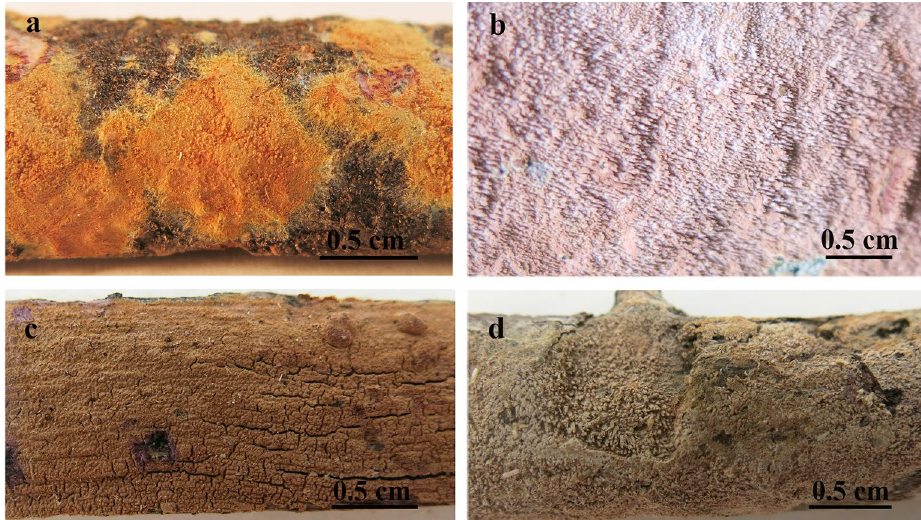
Figure 5. Xylodon magallanesii , ( a ) 20008Tell, MA-Fungi 90397, holotype, basidiome, dry specimen; ( b ) 15637MD, MA-Fungi 91819, basidiome, wet specimen. Xylodon australis , ( c ) P. Wellman 697, CANB 869100, basidiome, dry specimen. Xylodon lenis , ( d ) SH Wu 890714-3, H 7027389, isotype, basidiome, dry